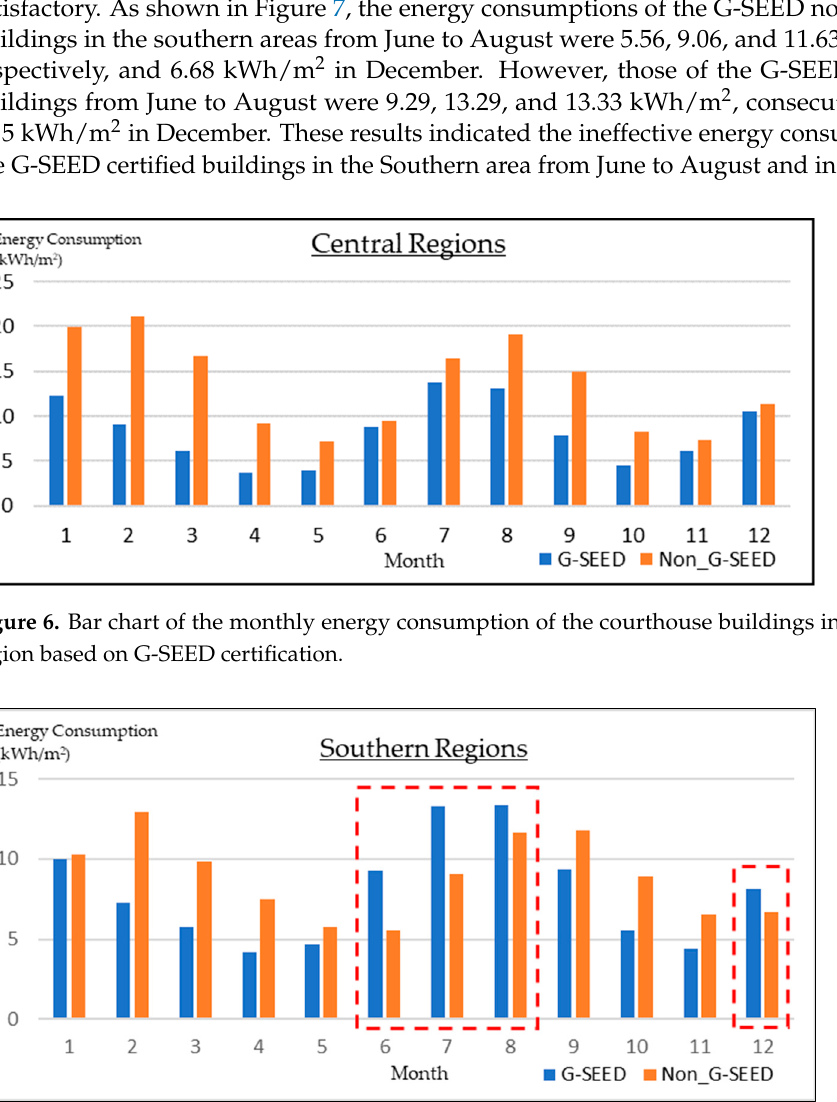
Figure 5. Line chart of the energy consumption of the courthouse buildings based on region and G- SEED certification.